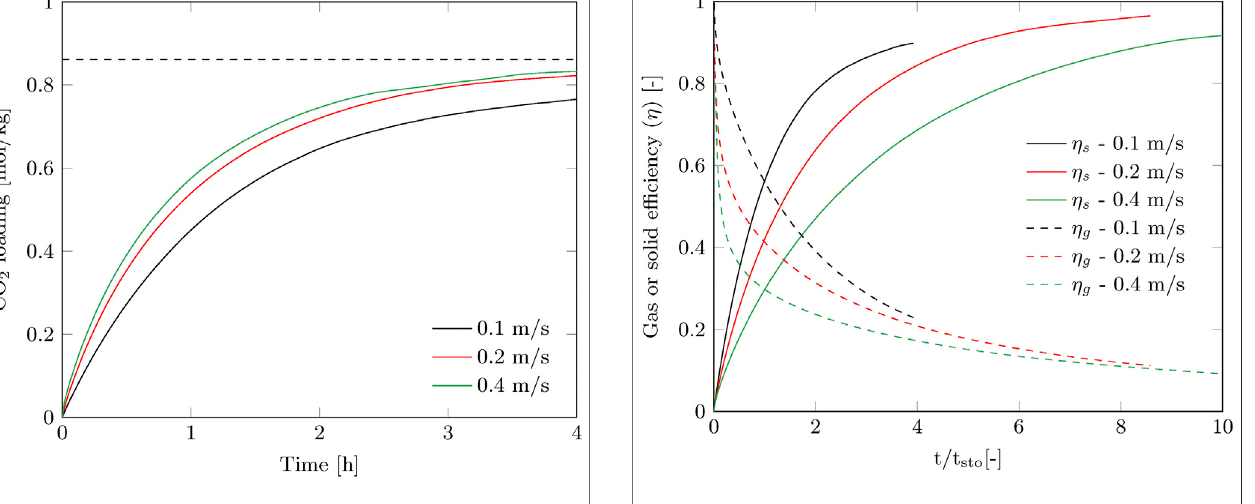
< 0 . 24m / s), irregular g